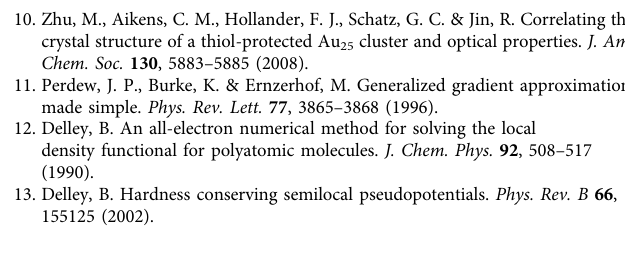
Fig. 1 Structural models and selected Kohn-Sham orbitals. a Structural model of Au 25 (RS) (cid:2) complexes are for clarity shown as lines. d The structure and 1 S orbital of Au þ Au (orange), S (yellow), C (gray) and H